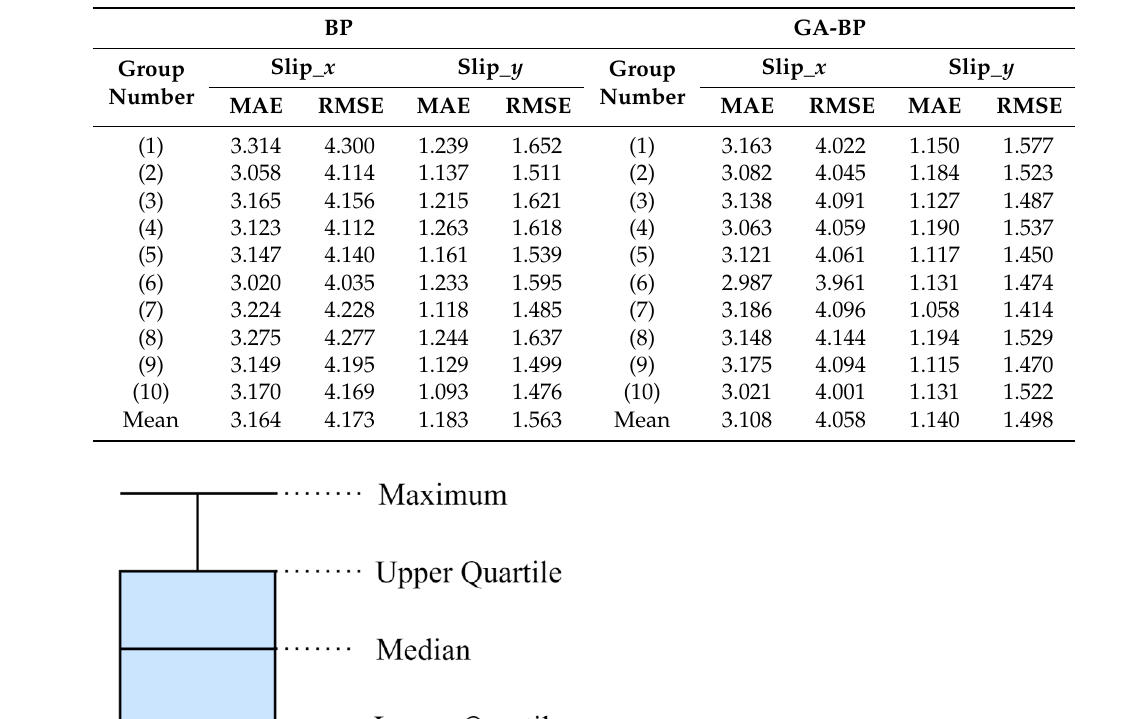
Table 3. Prediction results of BP and GA-BP.